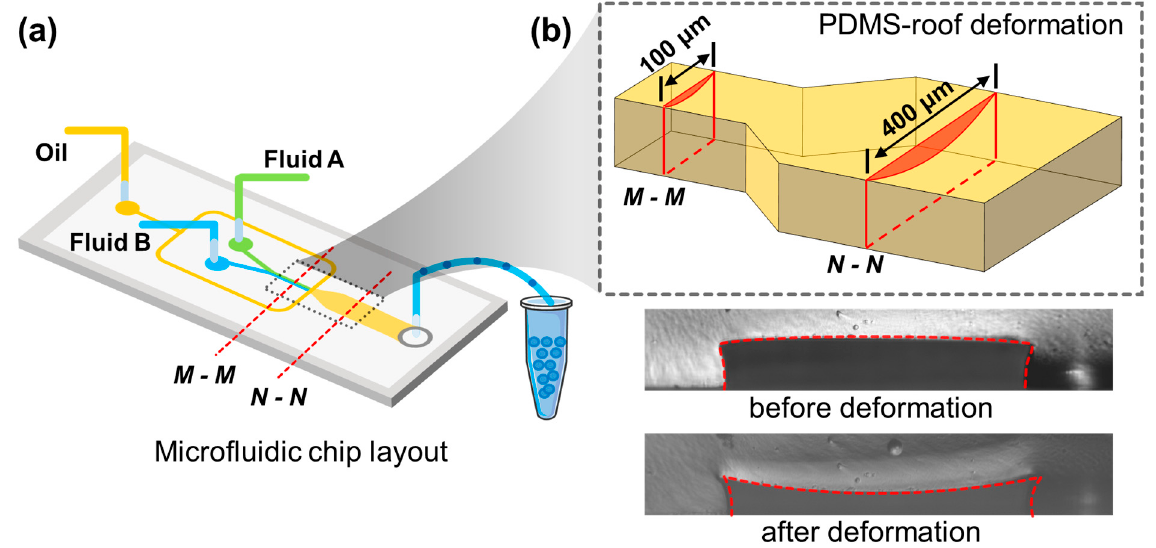
Figure 1. Schematic of experiment platform. ( a ) Oil, fluid A, and fluid B are introduced into the microchannel separately. Droplets are generated, mixed, and then collected into a centrifuge tube. ( b ) The enlarged image shows the subsidence of the channel roof at 100 µ m width and 400 µ m width. The two pictures below demonstrate the cross-sections of the microchannel before and after deformation.